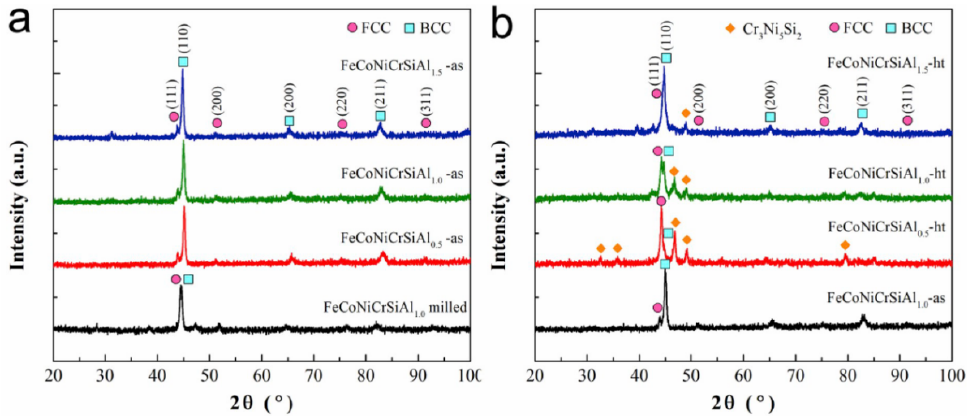
Figure 4. XRD patterns of the plasma-sprayed FeCoNiCrSiAl x HEA coatings: ( a ) as sprayed and ( b ) heat treated at 800 °C for 2 h [56].